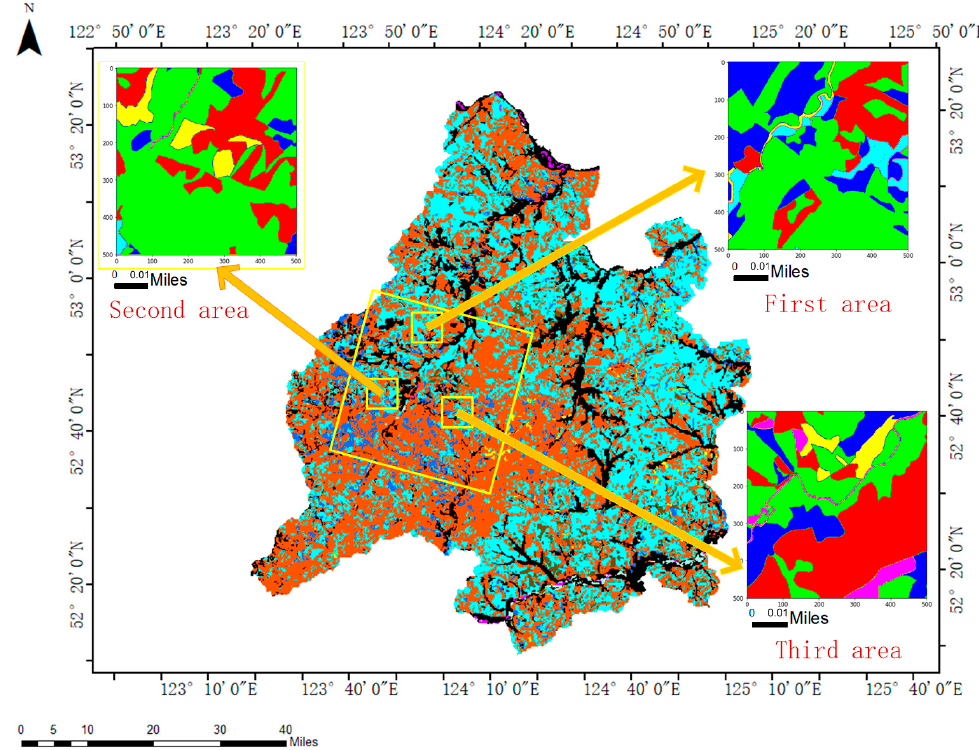
Figure 2. Map of three tree species datasets from the study area. Table 1. Tree species samples from three datasets of the study area. Birch